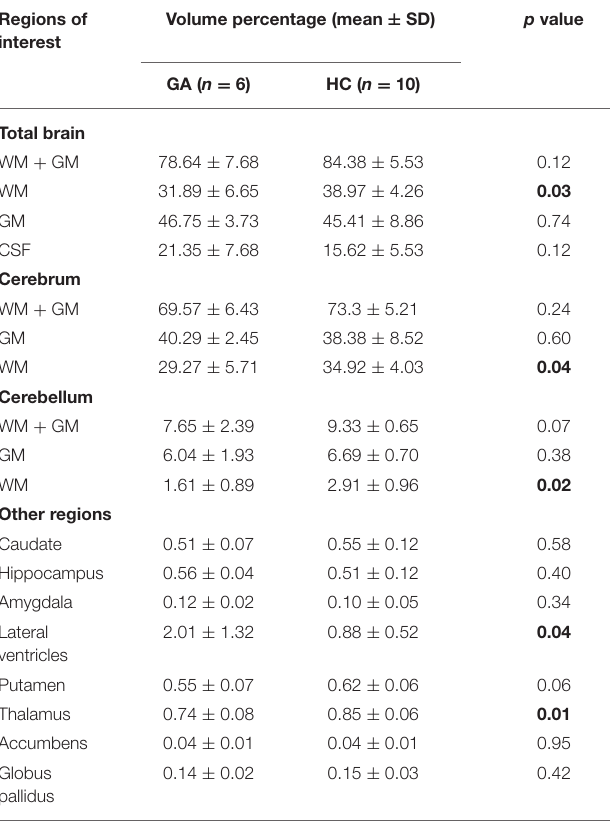
TABLE 3 | Volumetric analysis of individual cerebellar regions of patients with gluten ataxia (GA, n = 6) and healthy controls (HC, n =